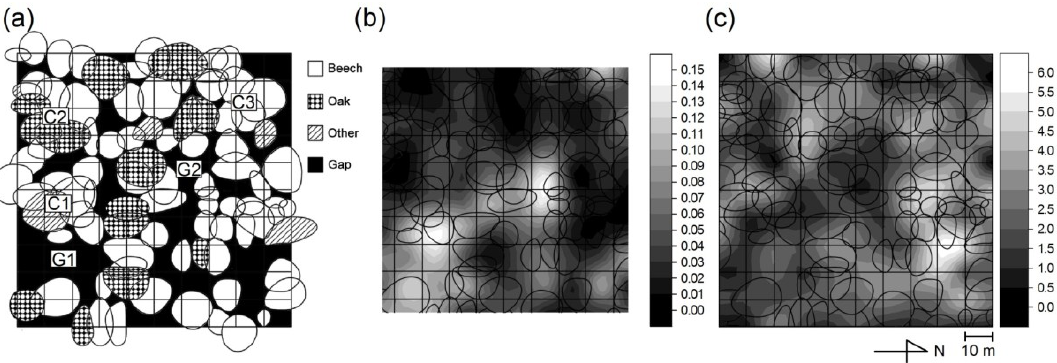
Figure 1. Five locations for measurement of soil respiration ( R s ) and environmental factors based on the crown projection diagram ( a ); the basal area in the sub-tree layer ( b ); and the density of dwarf bamboo ( c ) (from Suchewaboripont et al. [24]). Basal areas of sub-trees (DBH < 25 cm) and stem densities of Sasa are presented as m 2 and stem numbers m −2 , respectively.